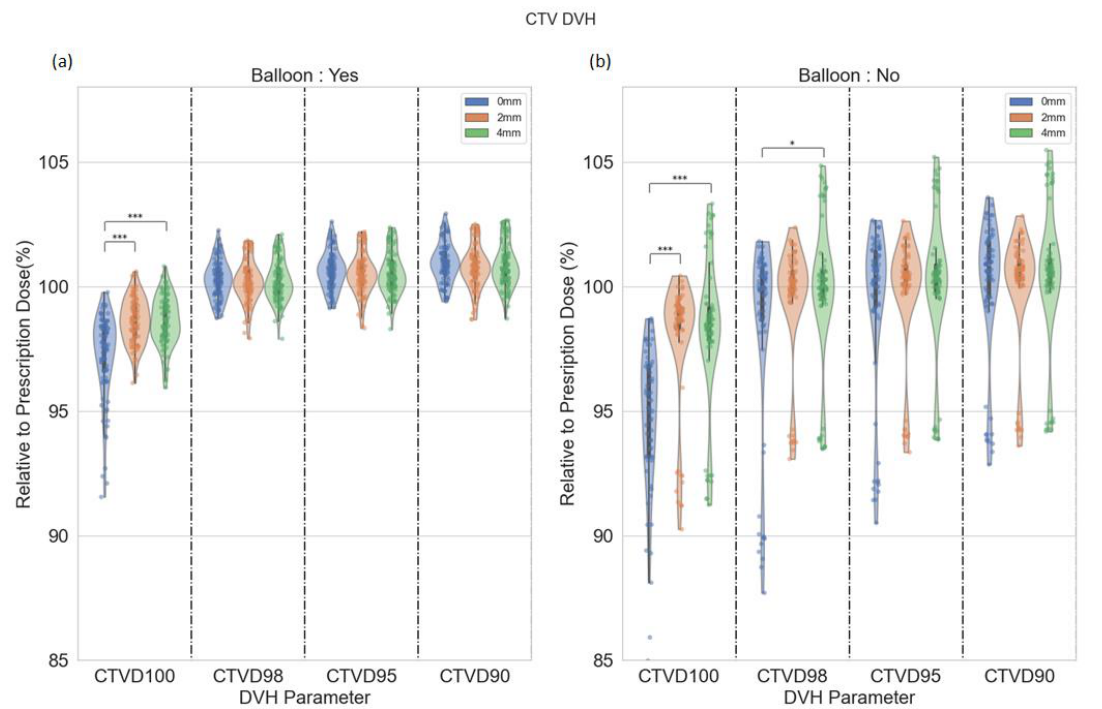
Figure 2. Violin plot for CTV DVH parameters for patients with ( a ) and without ( b ) a endorectal balloon. The annotation ‘*’ denotes statistical significance with p ≤ 0.05, and ‘***’ denotes p ≤ 0.001.